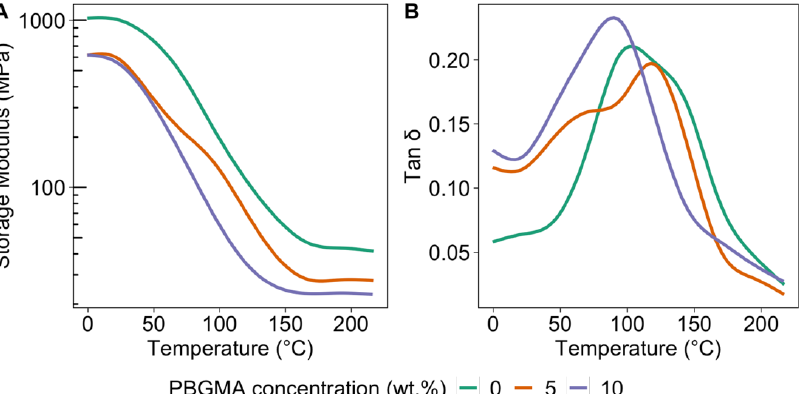
Figure 3. ( A ) Storage modulus and ( B ) tan δ curves of the reference mixture, 5 wt.%, and 10 wt.% PBGMA UV-cured films as a function of temperature, obtained by DMA.